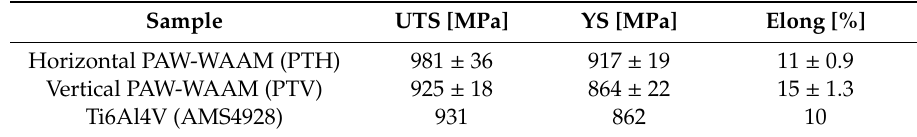
Table 6. Results of tensile testing of PAW-WAAM specimens. UTS: ultimate tensile strength, YS: yield